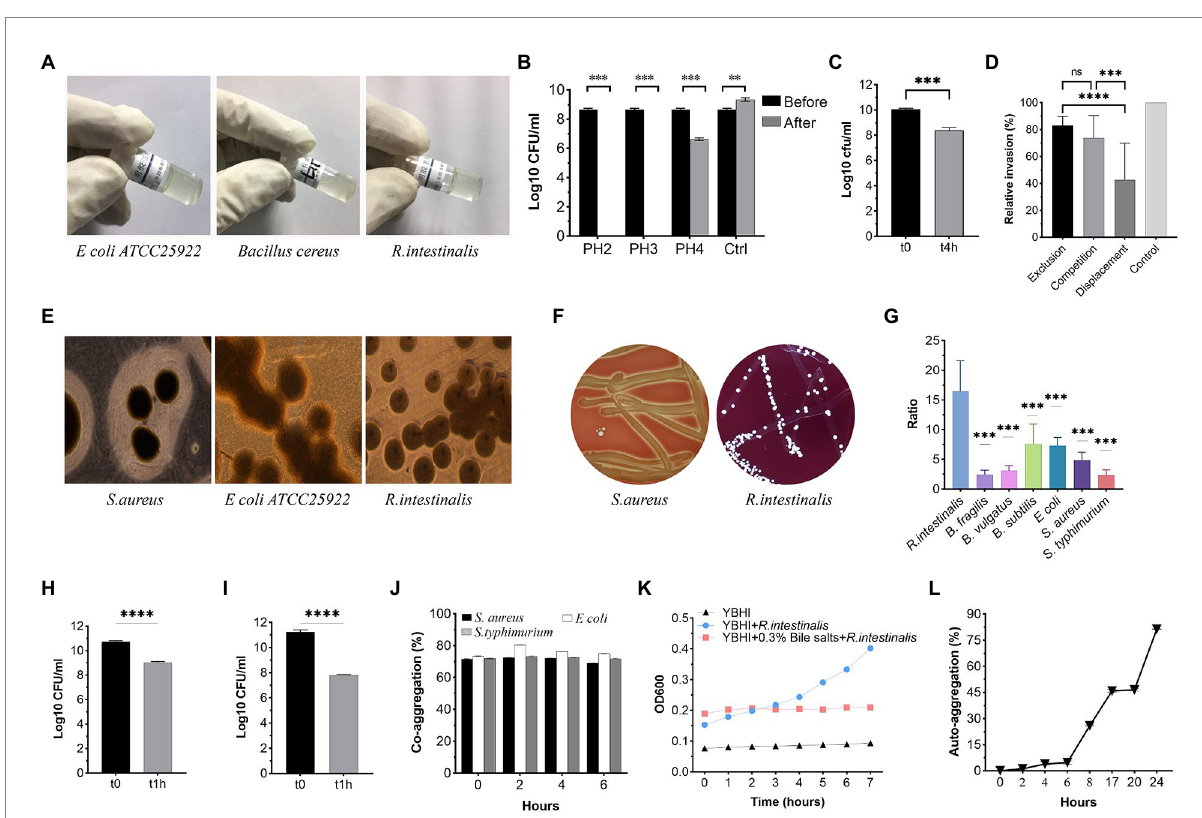
FIGURE 4 Phenotypic safety assessment of probiotic Characteristics. (A) Gelatinase activity of R. intestinalis compared to Bacillus cereus ATCC 14579 (positive control) and E coli ATCC 25922 (negative control). (B) Acid tolerance. (C,K) Bile salt and artificial intestinal fluid tolerance. (D) Inhibition of internalization of pathogens. (E) DNase activity. A clear zone around the colony represents DNase activity. (F) Hemolytic activities. (G) Biofilm formation. The y-axis represents the ratio of the OD550 of the bacteria to the ODc. (H,I) Adhesion of R. intestinalis on Caco-2 and HT-29 cells. (J,L) Co-aggregation and auto-aggregation abilities. * indicates p < 0.05, ns indicates no significance.